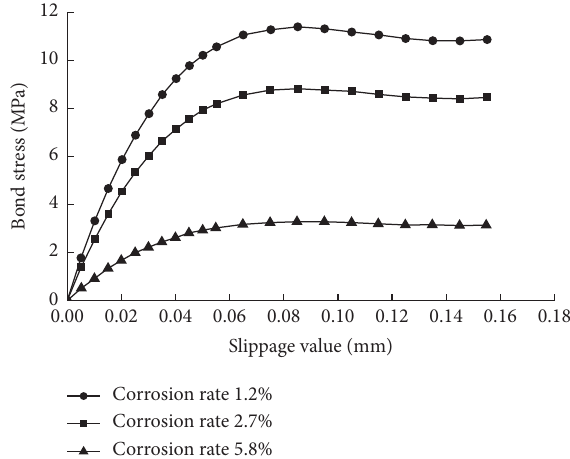
Figure 5: Adhesive–slippage relationship at different corrosion